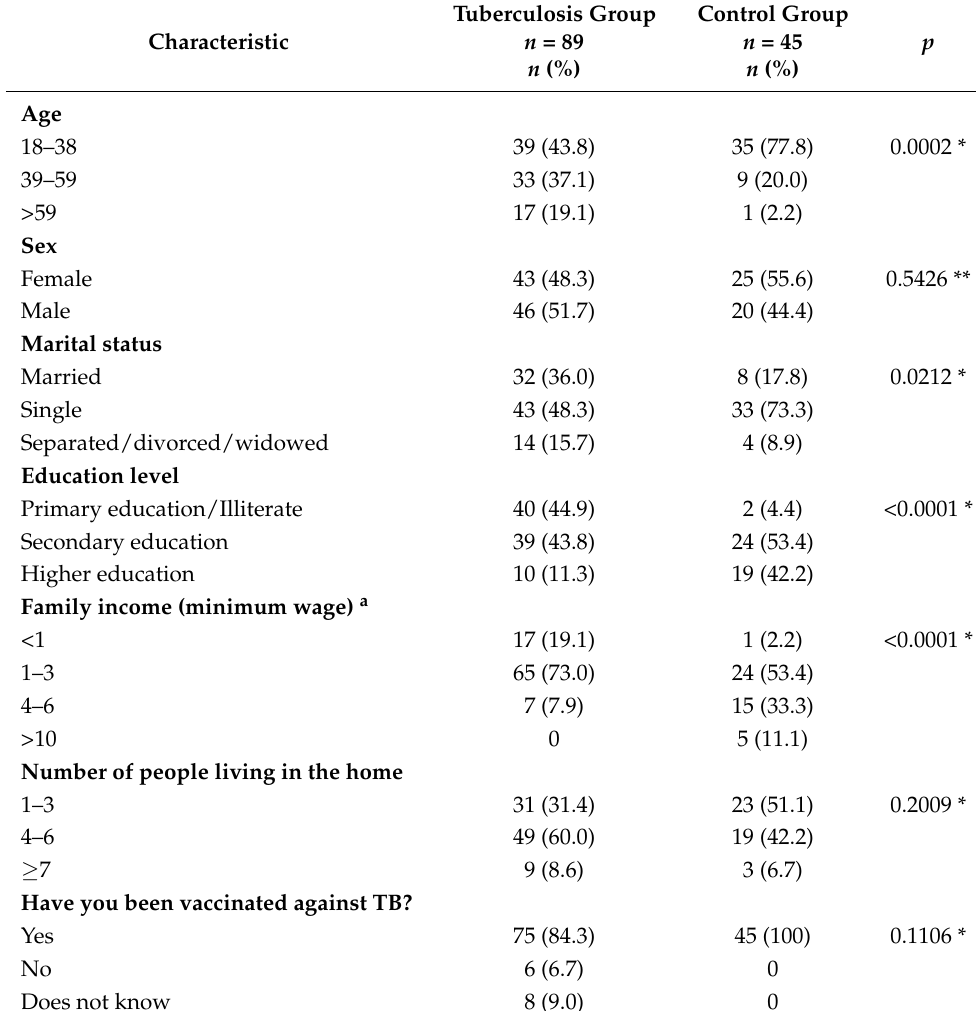
Table 1. Epidemiological characterization of patients with TB and individuals in a control group.